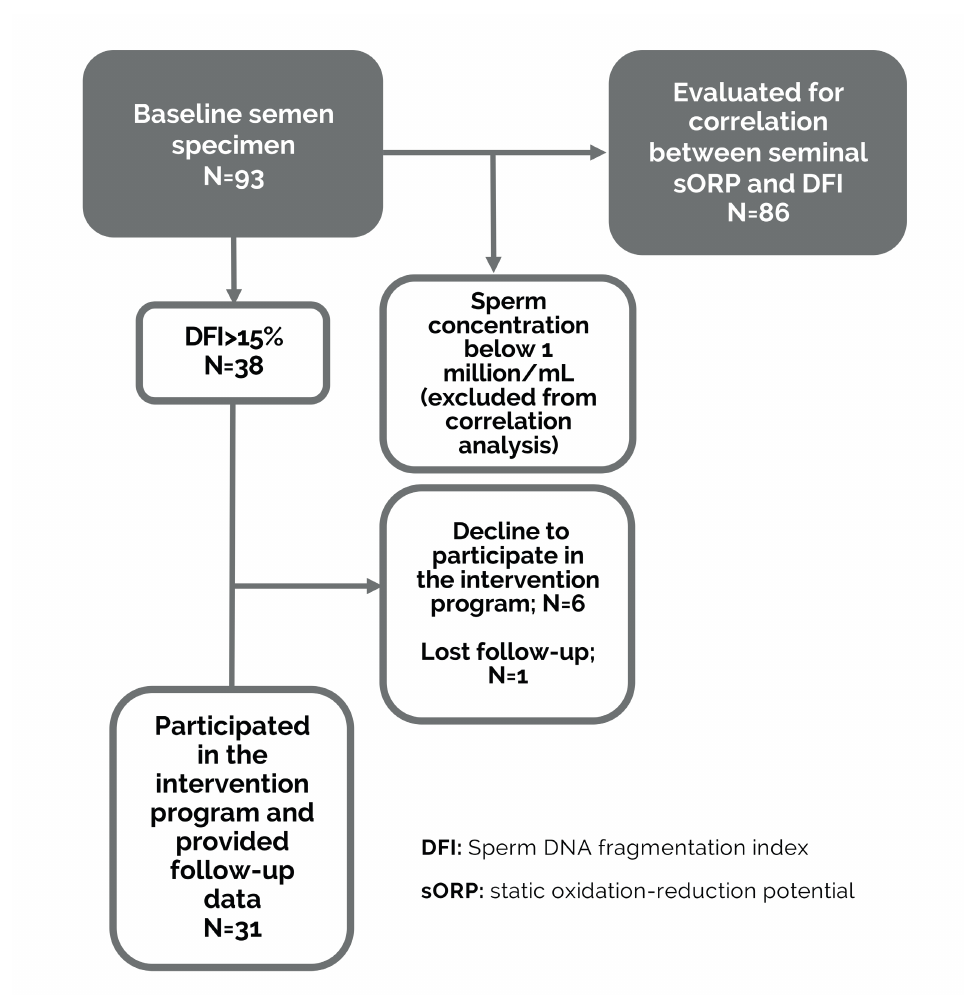
Figure 1 - Flow diagram showing total patient breakdown.